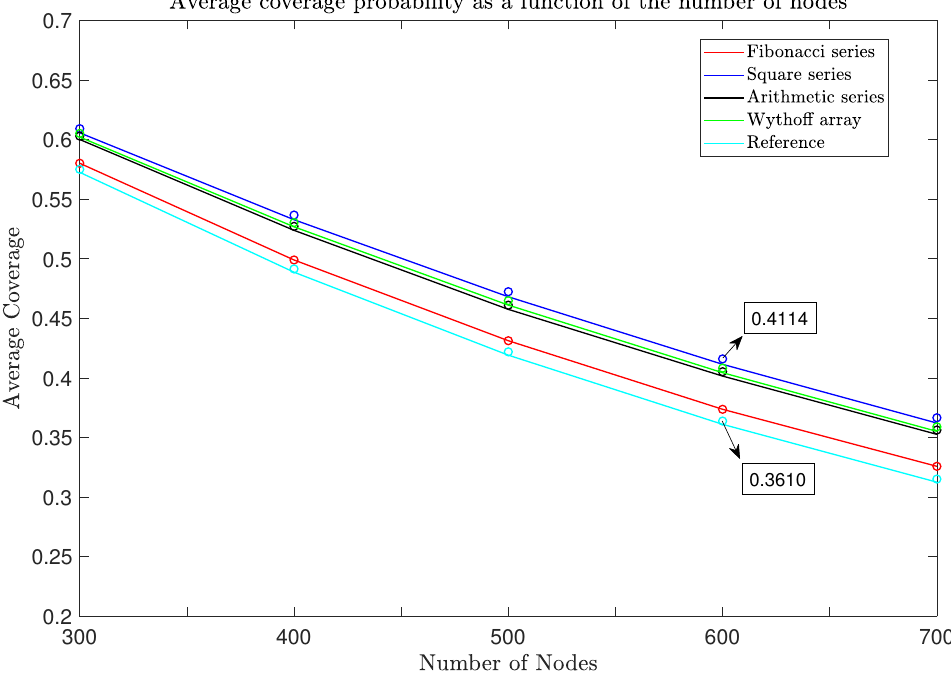
Figure 9. Comparison of the coverage probabilities of the LoRa uplink as a function of the number of nodes ranging from ¯ N = 300 to 700 nodes for the network size of R = 3 km with p 0 = 1% and path loss exponent η =